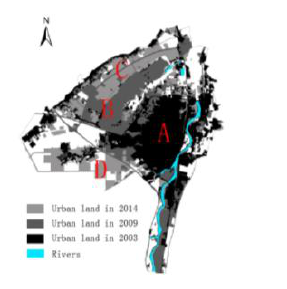
Figure 4. Diagram of evaluation